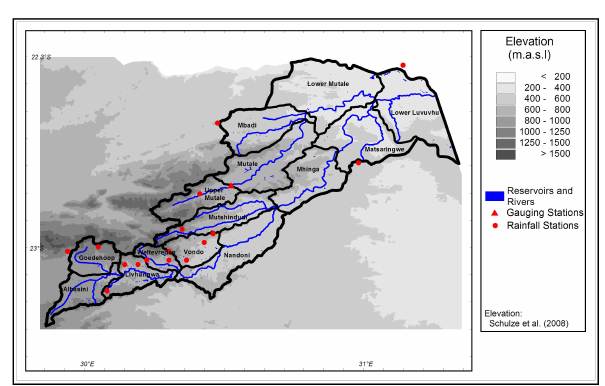
Fig. 4. Luvuvhu Water Management